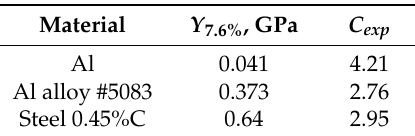
Table 2. Results of compression mechanical tests (yield stress at tension ( ε t = 7.6%) Y 7.6% , the value of C exp in tension